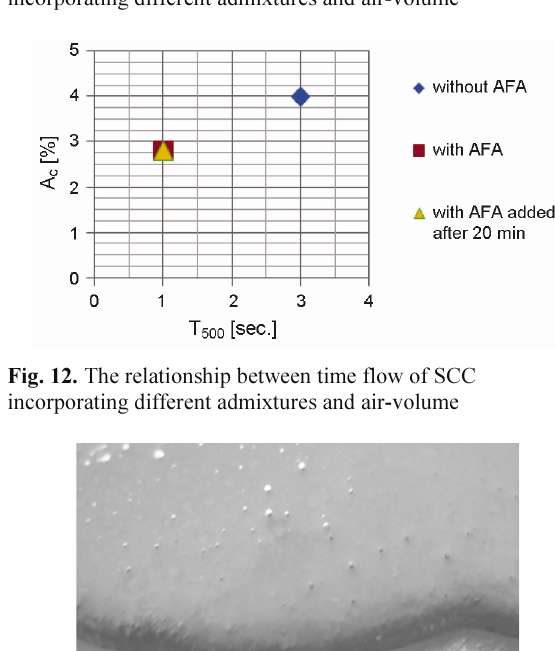
Fig. 11. The relationship between flow diameter of SCC incorporating different admixtures and air-volume